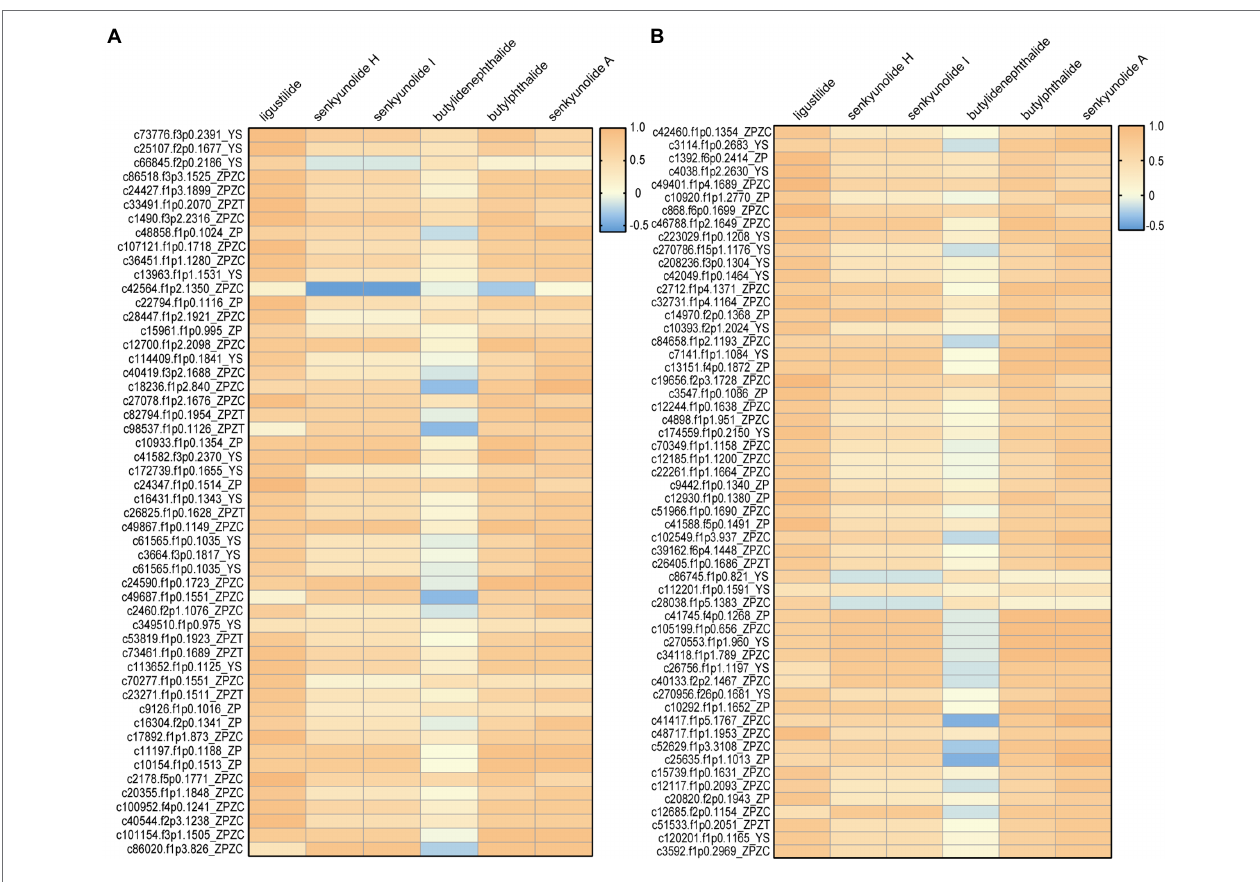
FIGURE 3 | The 108 isoforms that exhibited a significant positive/negative correlation with phthalide accumulation. (A) 1-54; (B)